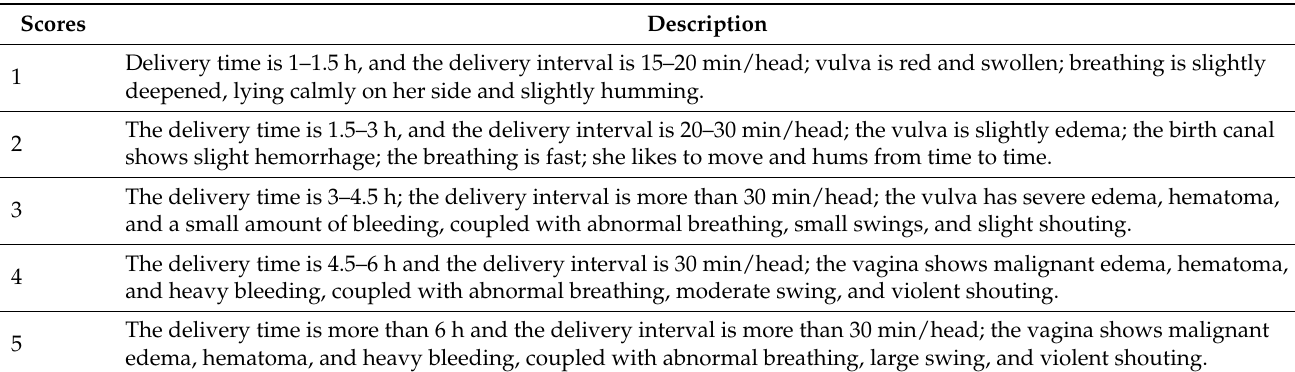
Table 3. Labor score for pregnant